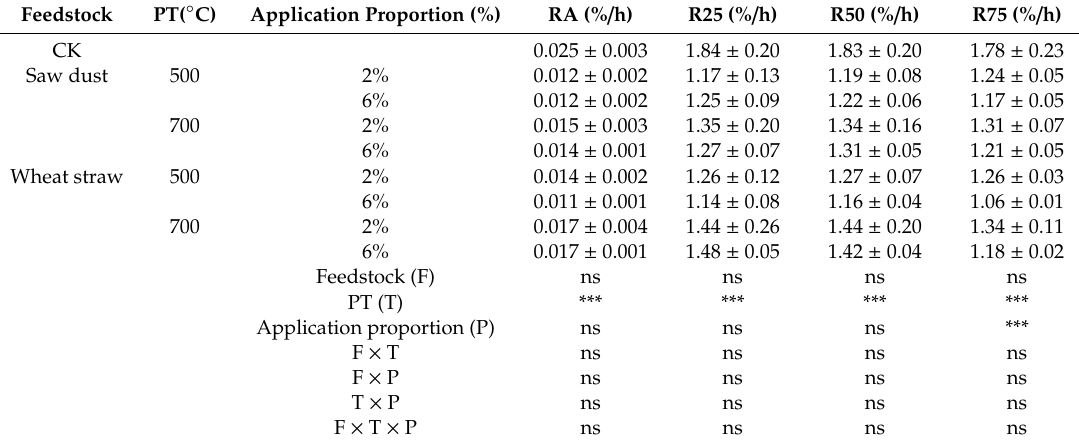
Table 3. Soil evaporation rate under treatments of four pyrochar (SPC500, SPC700, WPC500, and WPC700) and two application proportion (2% and 6%).